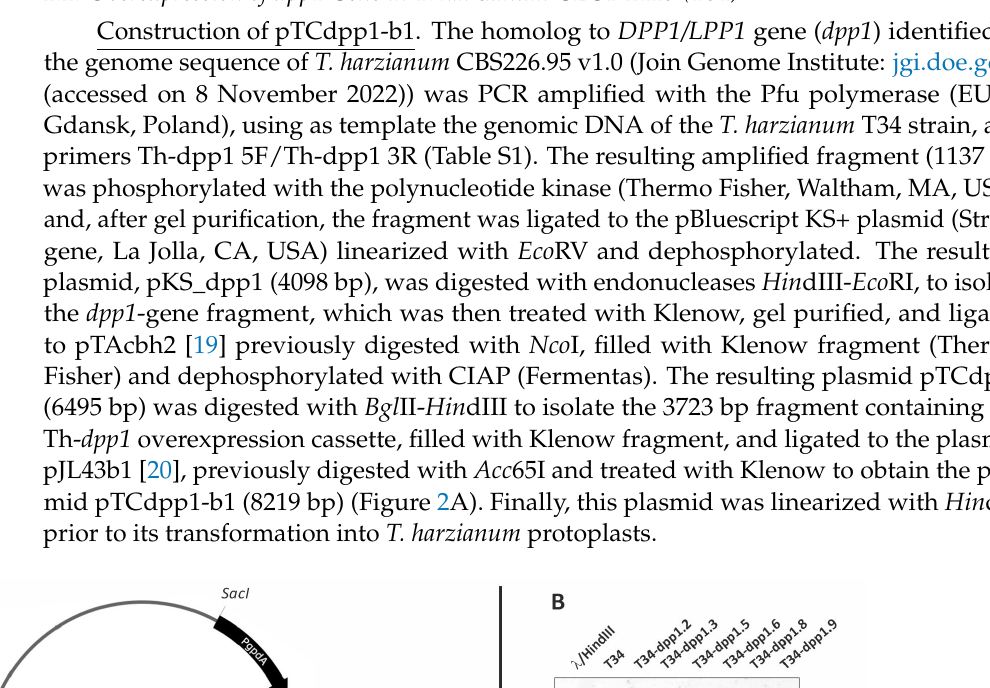
prior to its transformation into T. harzianum protoplasts.